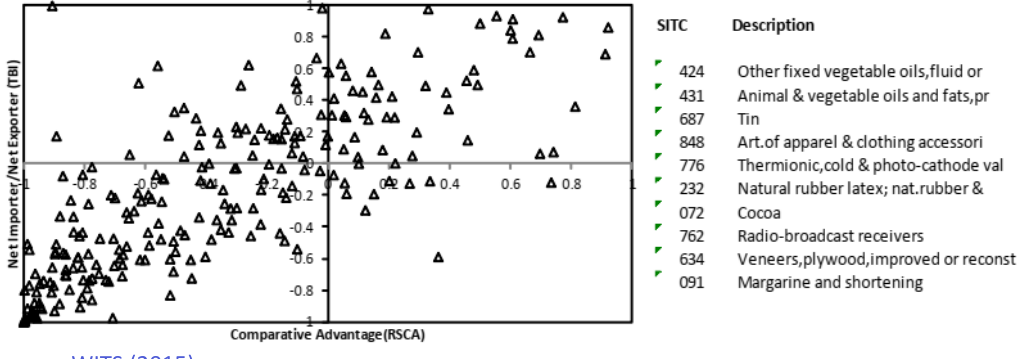
Figure 10: Products Mapping and the Top-Ten Export Products of Malaysia, 1997